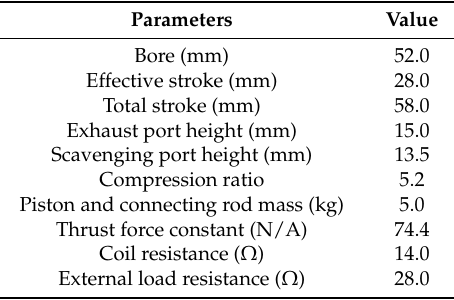
Table 1. The geometric and initial simulation parameters of the